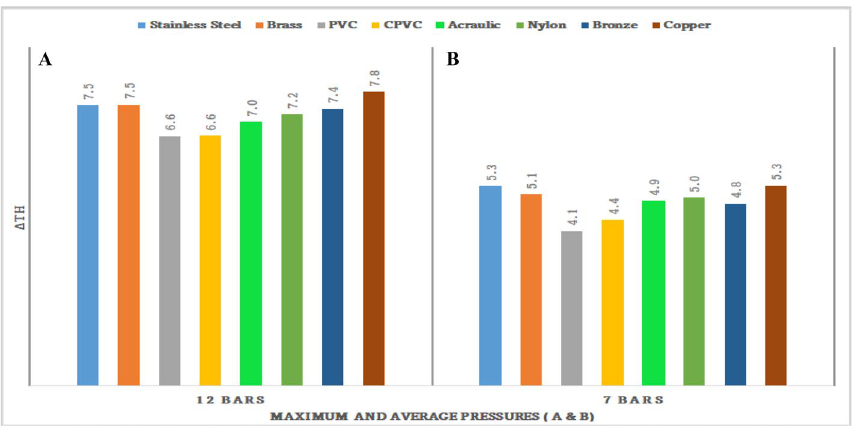
Figure 73. Hot end temperature difference versus maximum and average pressures.